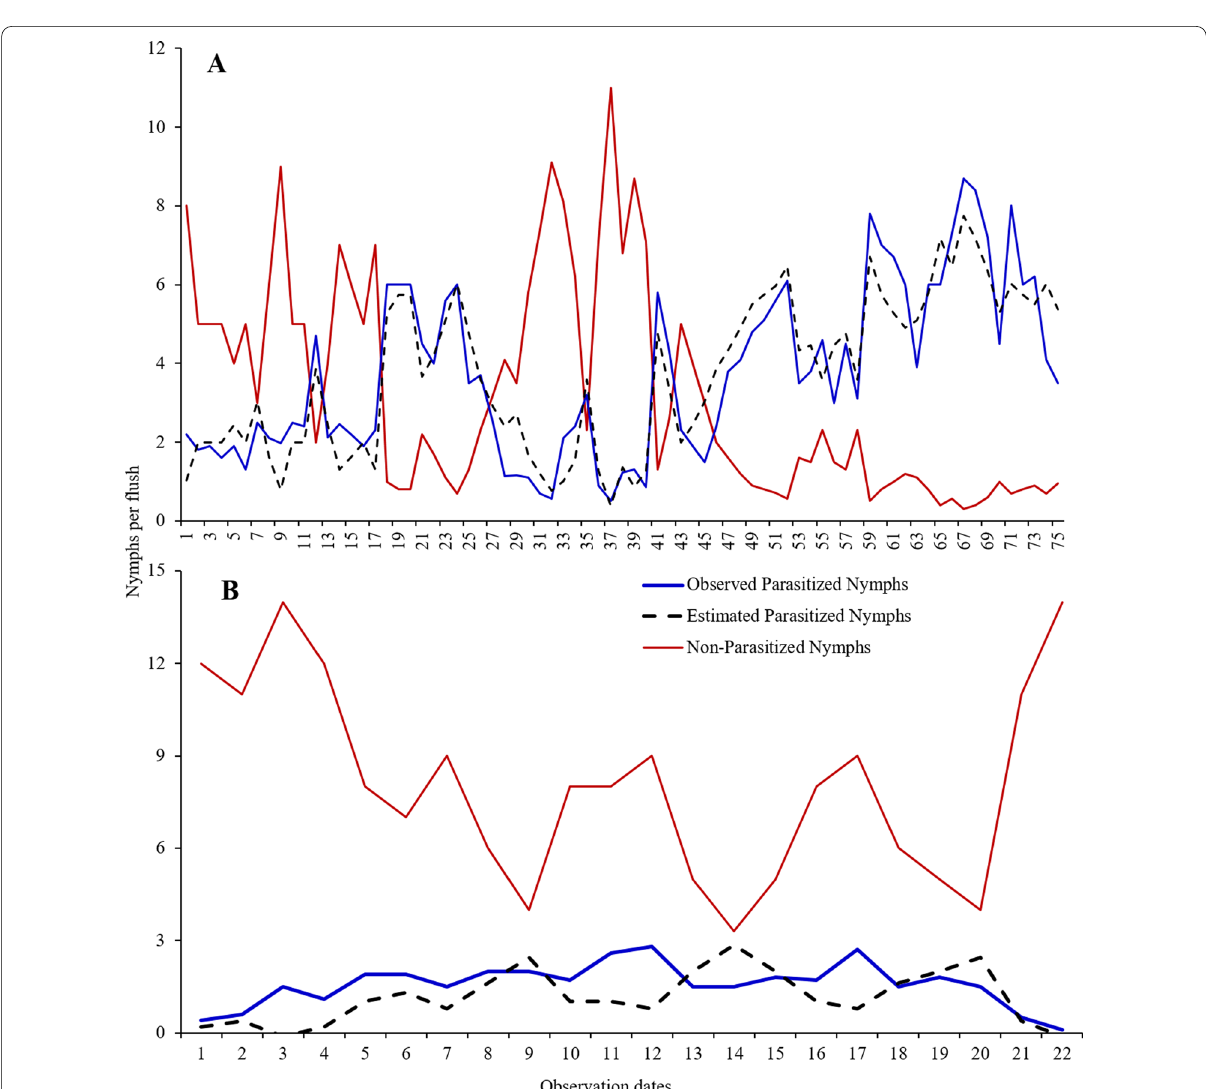
Fig. 4 Nymphs of Diaphorina citri : observed parasitized and non-parasitized, as well as estimated parasitized on: a Murraya paniculata, b Citrus x